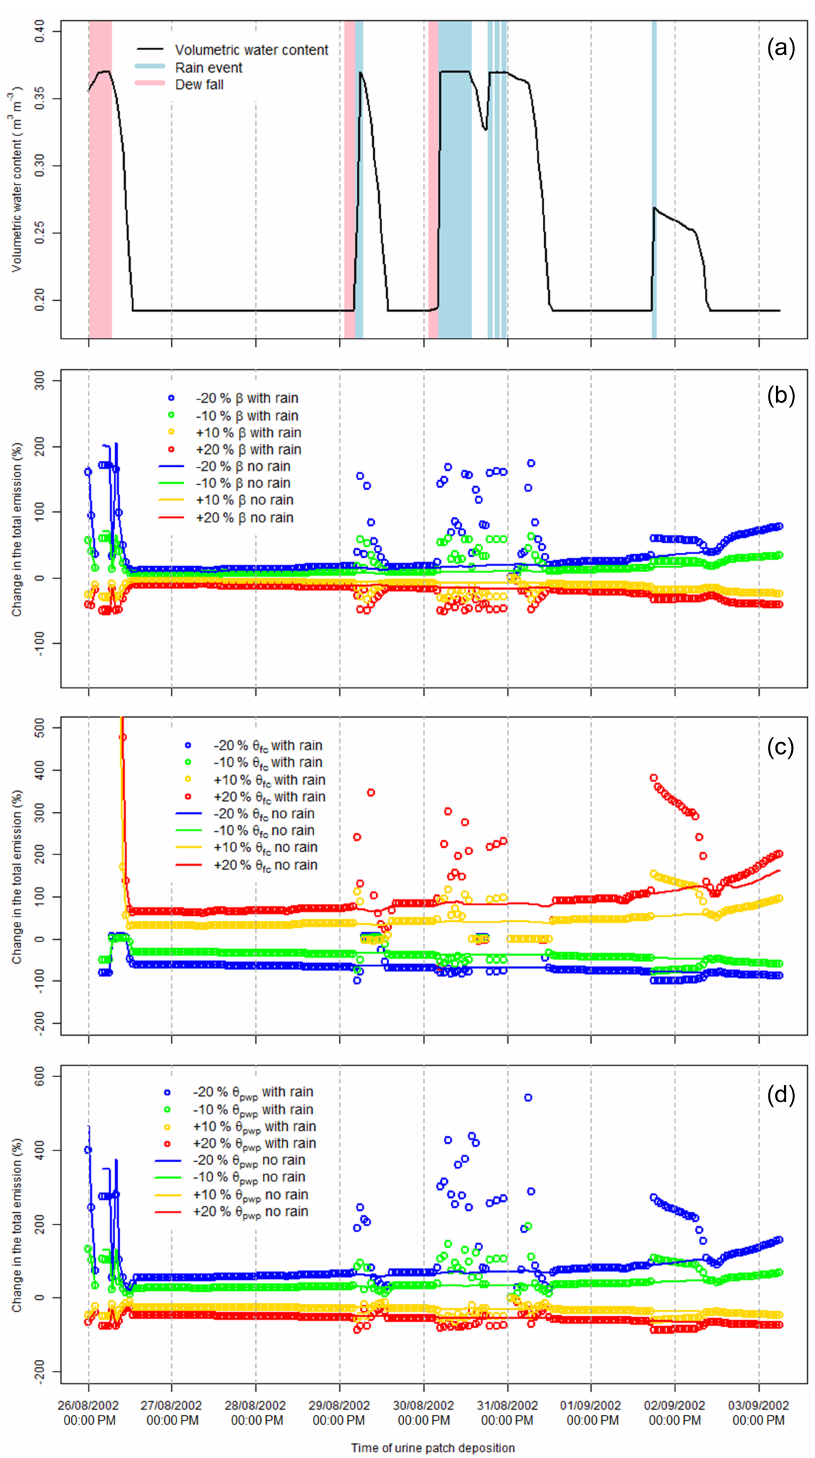
Figure 13. Results of the perturbation experiments for every single urine patch deposited over P2002. The results are shown in comparison with the volumetric water content of the soil at the time of urine patch deposition, changing in response to the events of precipitation and dewfall (a) . The investigated parameters were the buffering capacity ( β , b ), the field capacity ( θ fc , c ) and the permanent wilting point ( θ pwp , d ). In panels (b) – (d) , a point represents the percentage difference in the total NH 3 emission from the urine patch deposited in the given time step, and lines denotes the same, assuming zero precipitation over the modelling